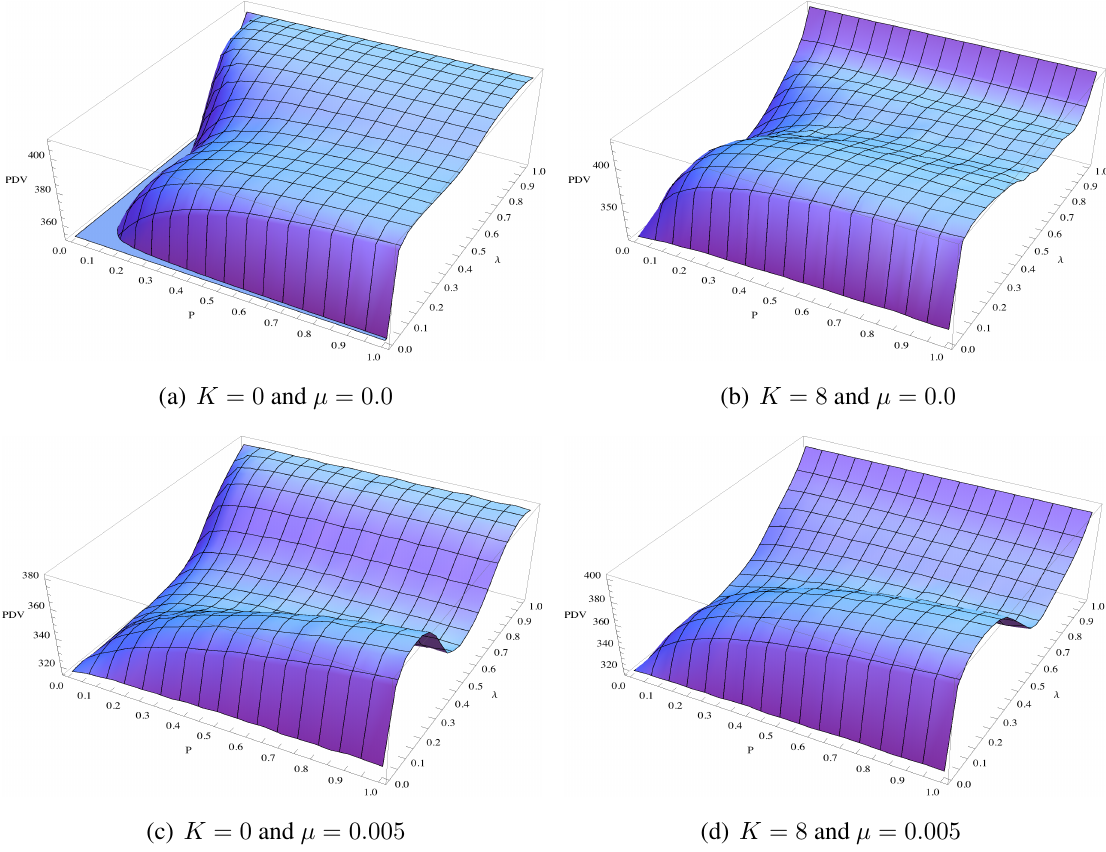
Figure 1. Average present discounted values (PDVs) of organizational performances for various p and λ in four combinations of task complexity ( K = 0 ( left ) and K = 8 ( right )) and environmental turbulence ( µ = 0 . 0 ( top ) and µ = 0 . 005 ( bottom )). Discount factor is δ = 0 . 999 . Data are generated by taking an average over 500 simulation runs for each set of parameter values.